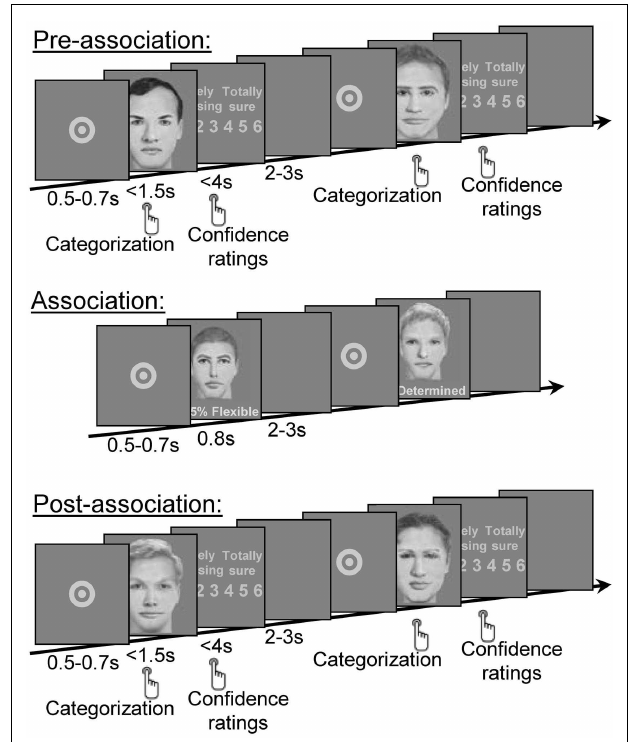
FIGURE 4 | Experiment 2, Experimental design of social categorization task. In pre- and post-association phase, each trial started with a central fixation point, followed by a face that subjects had to categorize as flexible or determined as quickly as possible and before the face disappearance. The face remained on-screen until subjects’ response or for up to 1.5s. In pre- and post-association phase, a confidence rating screen was presented. Subjects had to rate the confidence they had in their personality judgment between one (random guess) to six (absolutely sure). Inter-trial was initiated by subjects’ response or after up to 4s. In the association phase, after the fixation point a face was presented with the percentage of persons that had categorized this face as flexible or determined. Unknown to the subject, narrow inter-eye distance faces were systematically paired with a high percentage for one personality trait, while large inter-eye distance faces were systematically paired with a high percentage for the other personality trait, to induce an arbitrary association between personality trait and physical feature.There was no stimulus repetition across the successive phases of the study; every face and every face feature (including the eyes) were new for each phase.This procedure was replicated identically for non-social categorization task (with the category labels A and